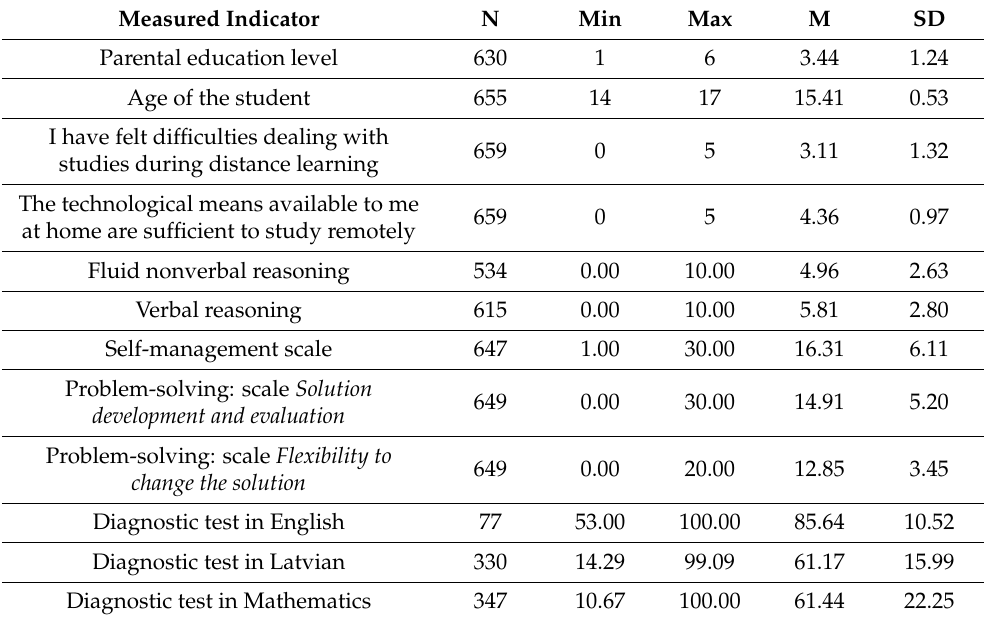
Table 1. Descriptive statistics of the indicators measured in this